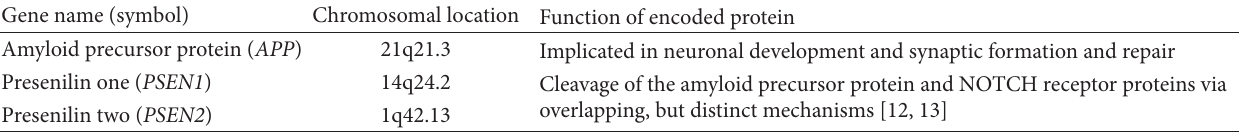
T 1: Genes responsible for early onset Alzheimer’s disease, including chromosomal location and